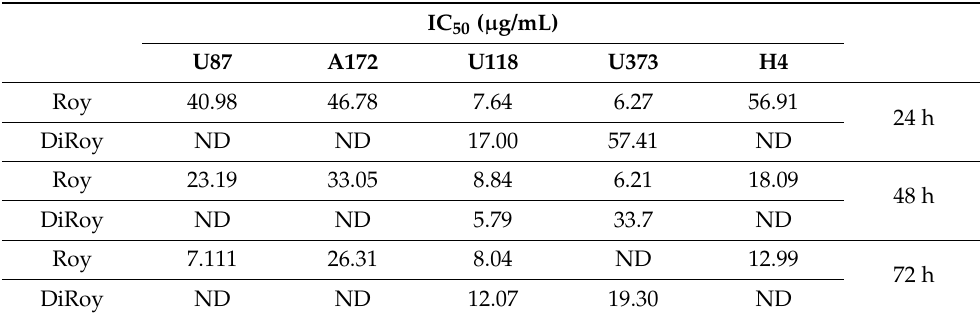
Table 4. Cytotoxic effects of Roy and DiRoy isolated from P. hadiensis towards five GB cell lines. IC 50 values of each three independent experiments are shown.